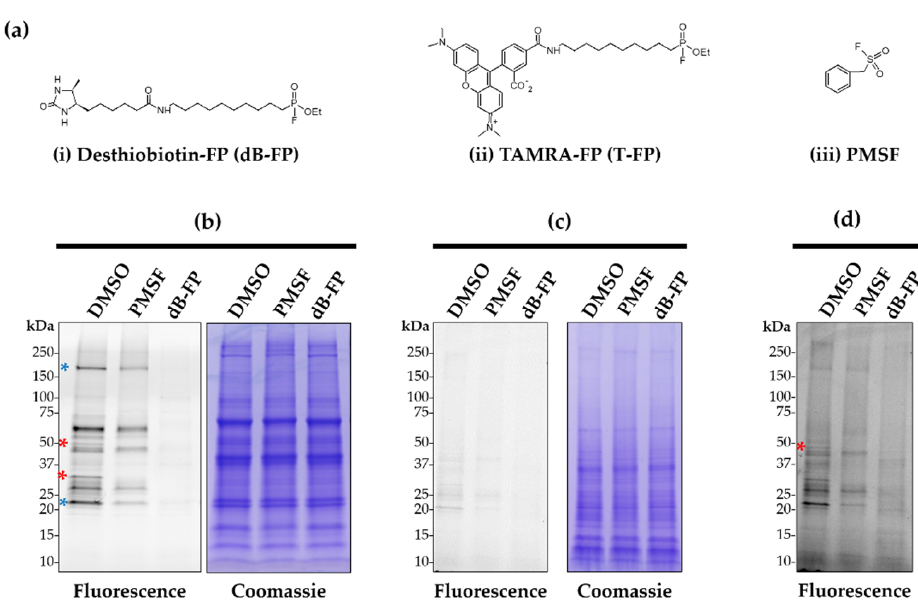
Figure 4. On-gel fluorescence labelling of zebrafish serine hydrolases. ( a ) Structures of the FP probes (T-FP and db-FP) and serine hydrolase inhibitor (PMSF) used. ( b ) One-dimensional gel visualization of the soluble protein fraction of labelled serine hydrolases. In vitro competitive profiling was performed by incubating the proteins at 25 ◦ C for 15 min with the competitor or DMSO (control without competitor), followed by labelling with the T-FP probe for 15 min. The competition was performed with 2 mM PMSF and 2 µ M dB-FP. After the fluorescence scan, the gel was stained with Coomassie blue to visualize the protein profile (right picture). ( c ) Competitive profiling of the membrane fraction as in ( b ). ( d ) Shows the high-contrast fluorescence scan of the insoluble fraction performed with ImageJ. A blue asterisk indicates an example of a protein whose labelling is partially inhibited by PMSF, while a red asterisk shows a protein whose labelling is totally inhibited (Figure